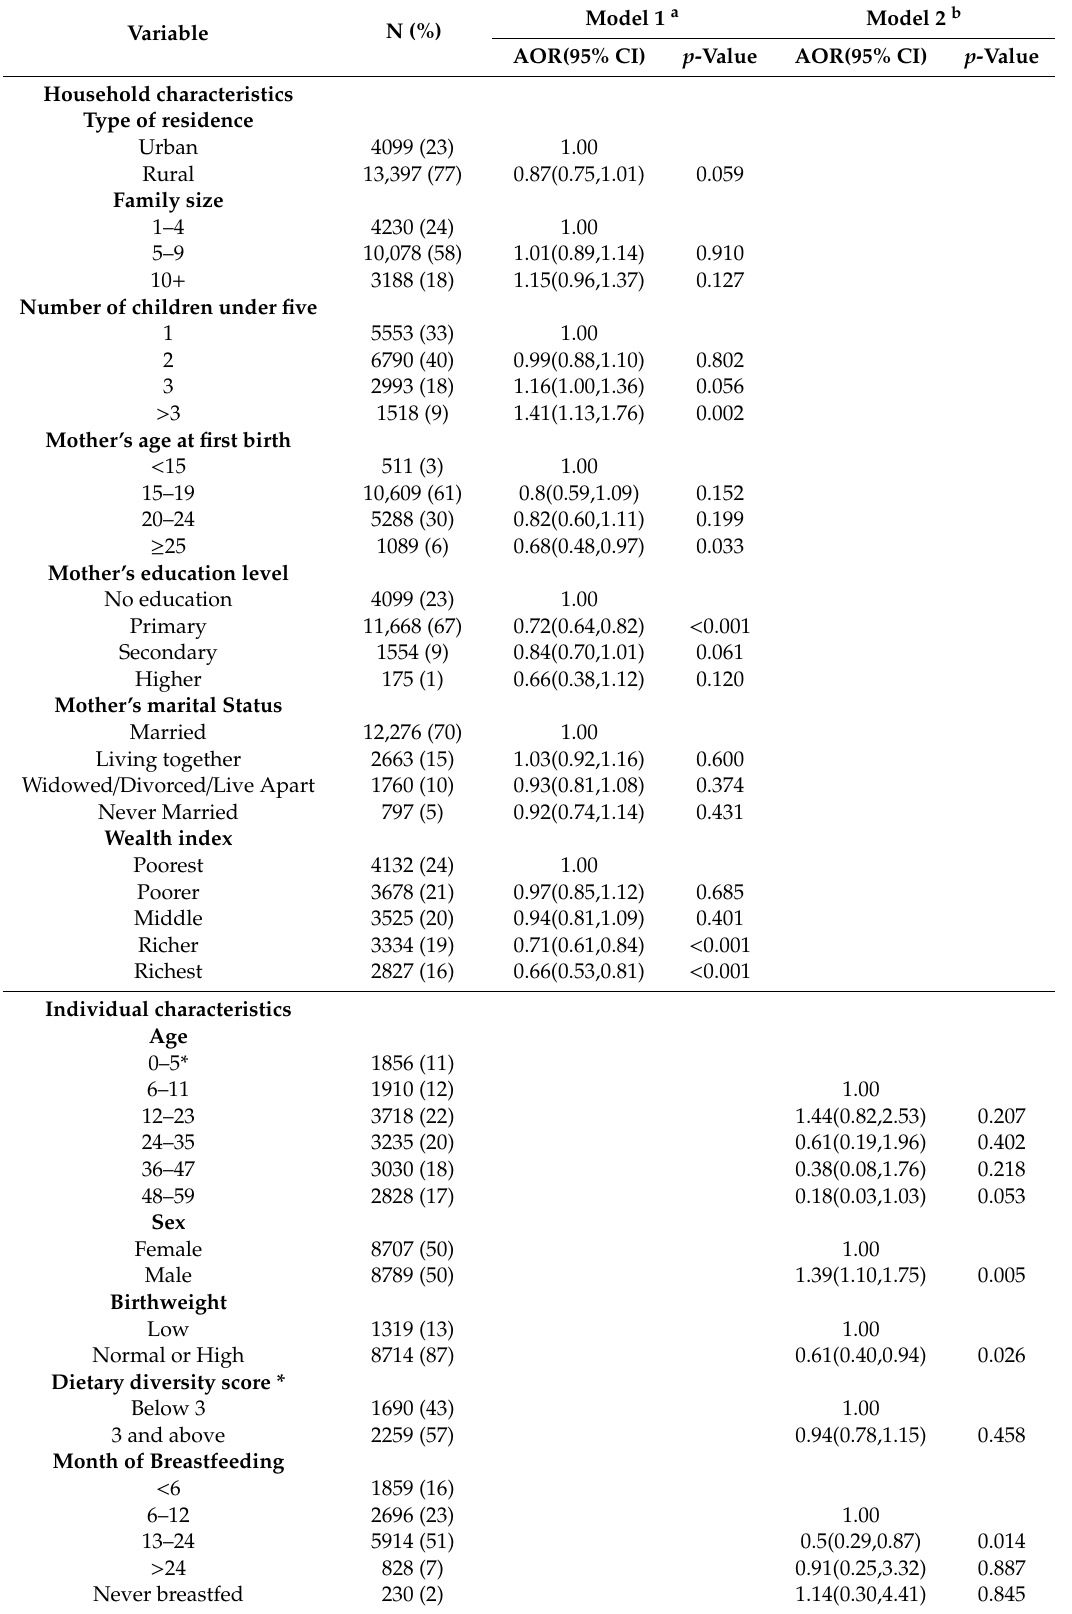
Table 4. Factors associated with child anemia using TDHS